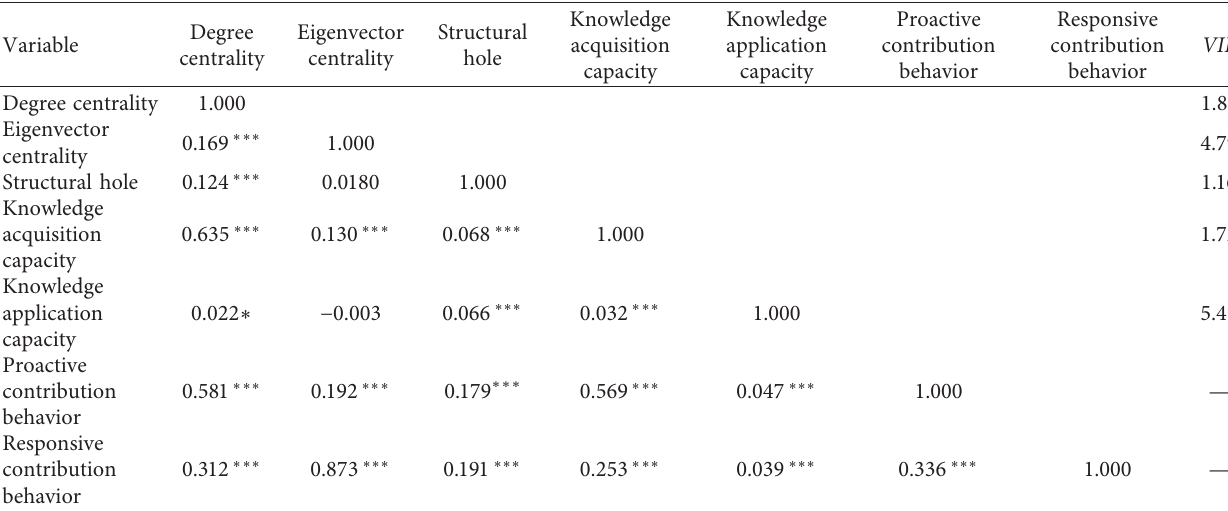
Table 4: The correlation coefficient and VIF value.